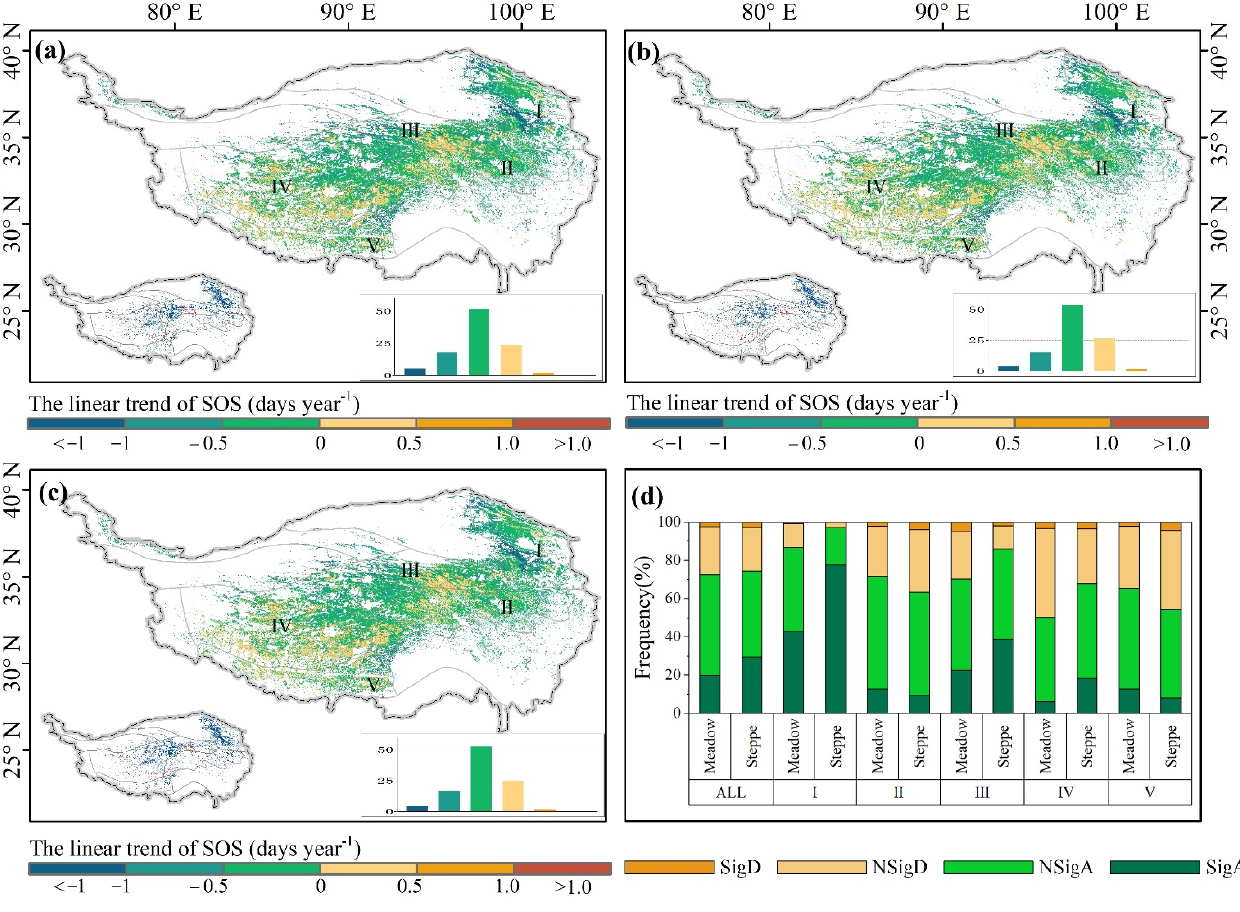
Figure 3. Spatial distribution and frequency statistics of linear trends of grassland spring phenology (SOS) from Polyfit ( a ); HANTS ( b ) and average of two methods ( c ) during 2000–2017 and frequency distribution of different trend types for steppe and meadow across different ecoregions ( d ). A negative value indicates an advance, and a positive value indicates a delay. Bottom-right and bottom-left insets in ( a – c ) show proportion of corresponding trends, indicated by map legend and spatial distribution of pixels with significantly negative (blue) and positive (red) trends ( p < 0.05), respectively. SigD indicates significantly delayed SOS ( p < 0.05). NSigD indicates delayed SOS but not significant ( p > 0.05). NSigA indicates advanced SOS but not significant ( p > 0.05). SigA indicates significantly advanced SOS ( p < 0.05). All indicates entire plateau. I, II, III, IV, and V indicate different ecoregions following Figure 1.